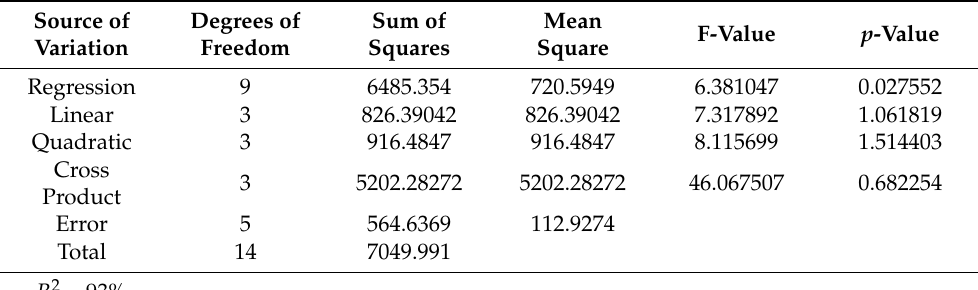
Table 3. Estimates of the model regression for Nudrin reduction under WSD:Mag-based oxida- tion